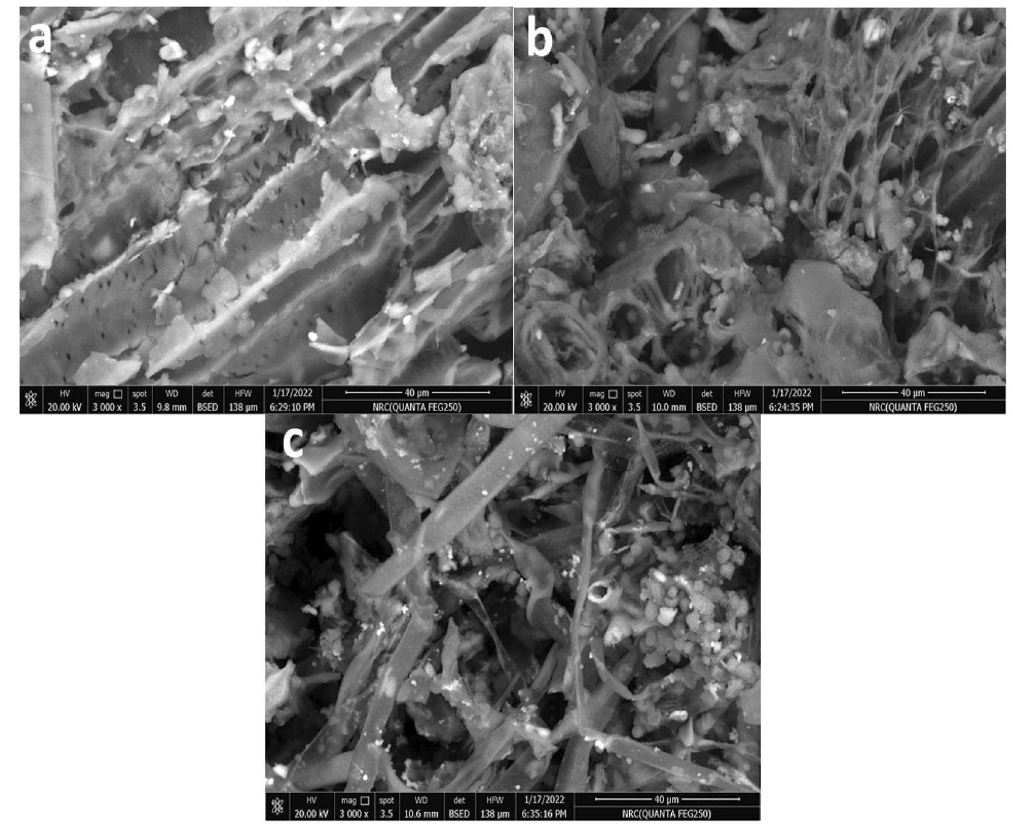
Figure 4. SEM image of blank sunflower fibers ( a ), and the treated sunflower fibers either via Sub conditions ( b ) or via SSF conditions ( c ).